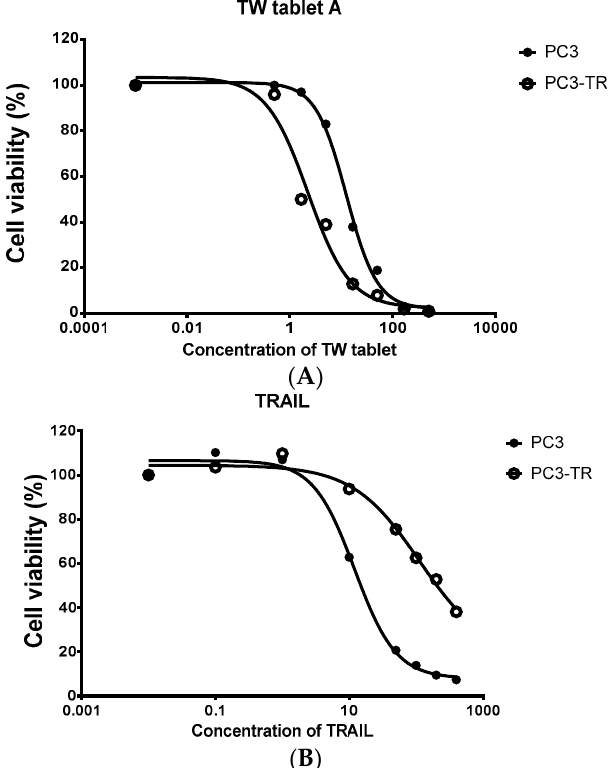
Figure 1. Cell viability (measured from triplicate samples) of a prostate cancer cell line (PC3) and its TRAIL resistant cell line (PC3-TR) treated with the extract of Tripterygium wilfordii (TW) tablet. ( A ) The cytotoxicity of TW tablets on PC3-TR was much more potent than PC3 (IC 50 of 2.3 vs. 12.6 μ g/mL for PC3-TR and PC3 respectively); ( B ) PC3-TR showed resistance to TRAIL (IC 50 of 512 vs. 18 ng/mL for PC3-TR and PC3 respectively).